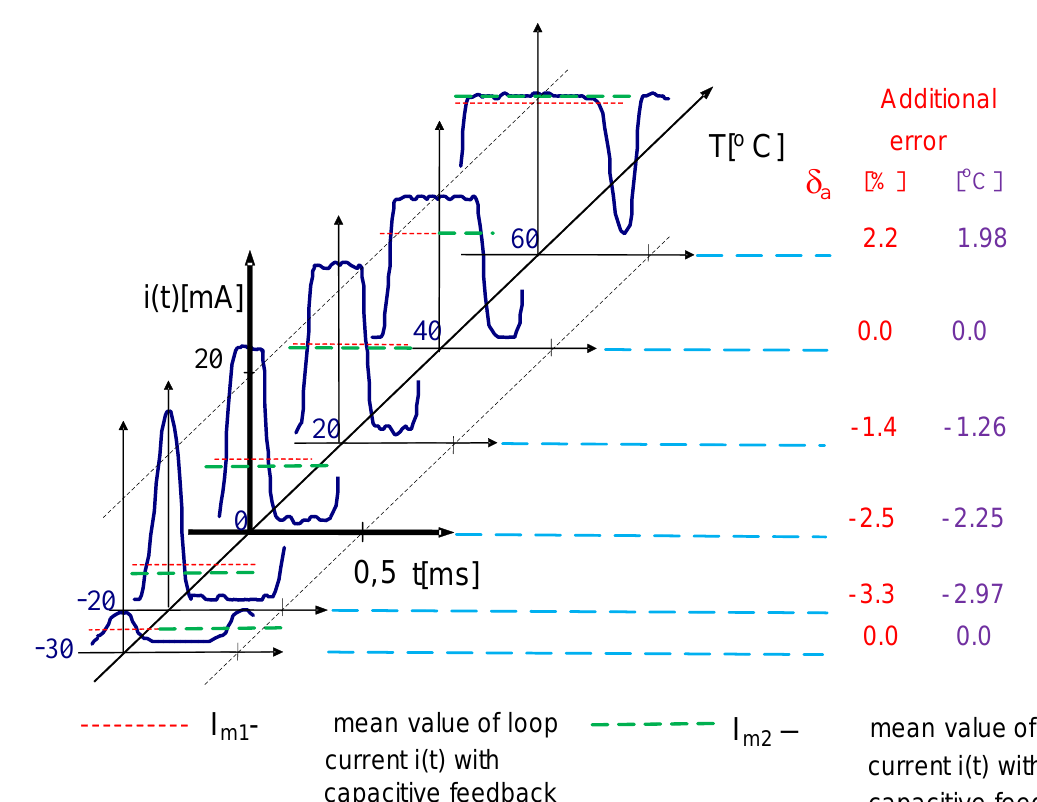
Figure 14. Graphical illustration of influence of unexpected alternating current on a measurement error.